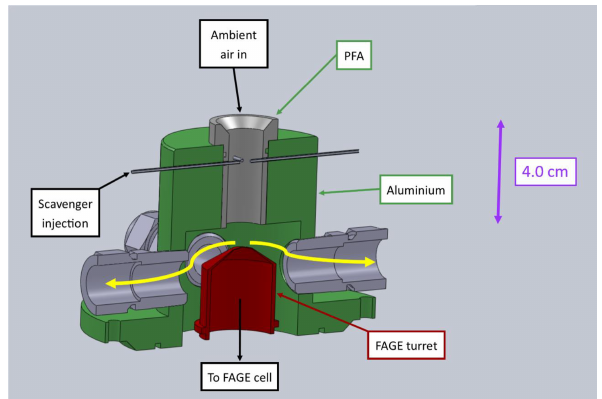
Figure 1. Labelled SolidWorks model of the Leeds inlet pre-injector (IPI). The scavenger is injected into the centre of the perfluo- roalkoxy (PFA) flow tube via four 0.25mm ID needles. The thick yellow arrows indicate the direction of the sheath